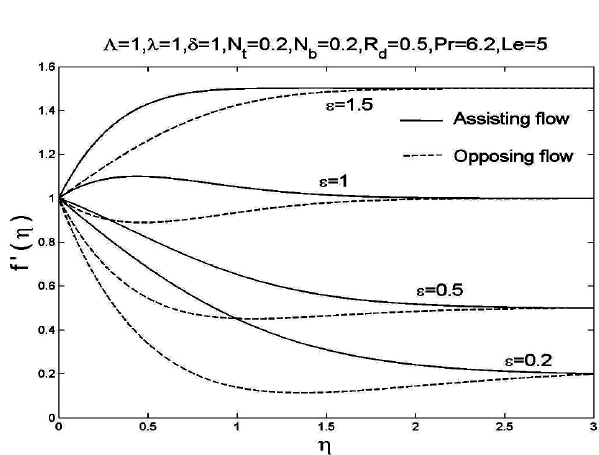
Fig. 5. The effect of the velocity ratio parameter on the velocity profiles ( ) f η′ .